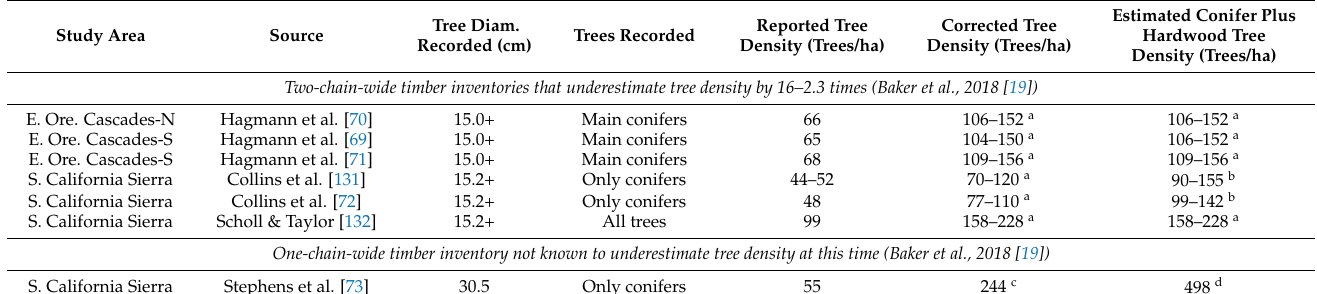
Table 7. Reported early timber inventory tree-density estimates and corrected estimates